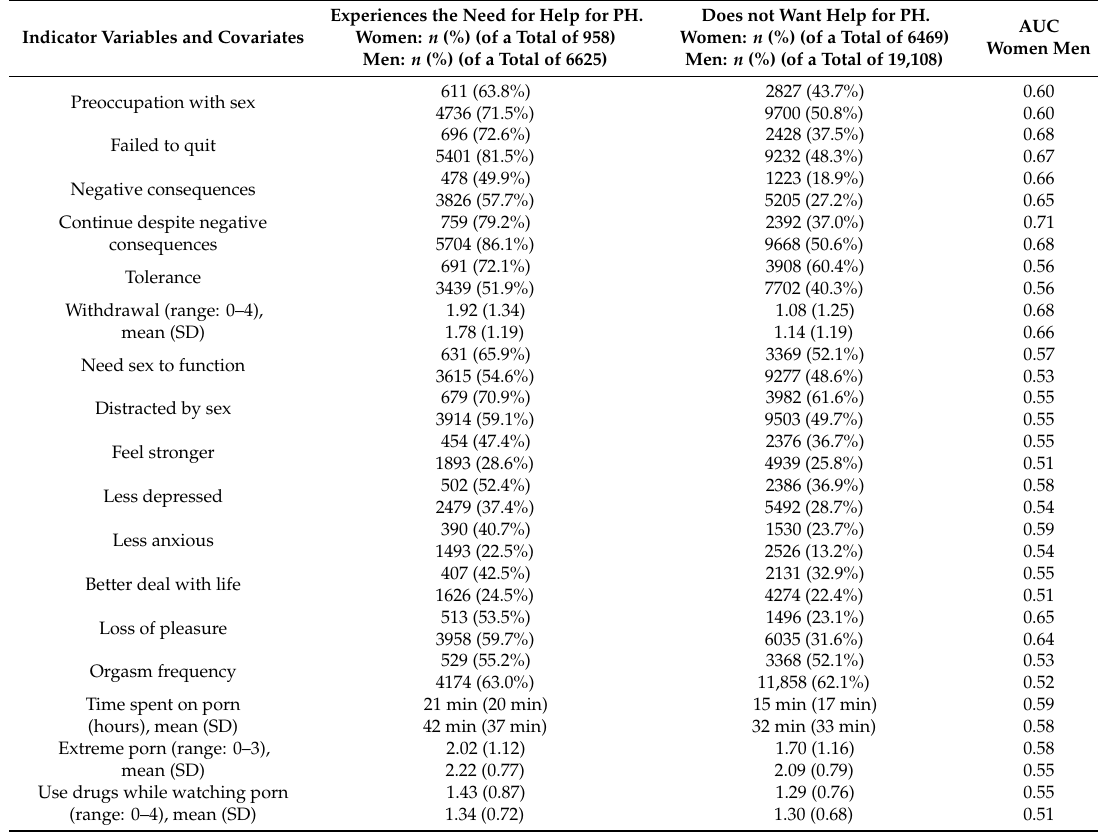
Table 1. Description of the sample accounting for gender and experiencing the need for help for problematic hypersexuality